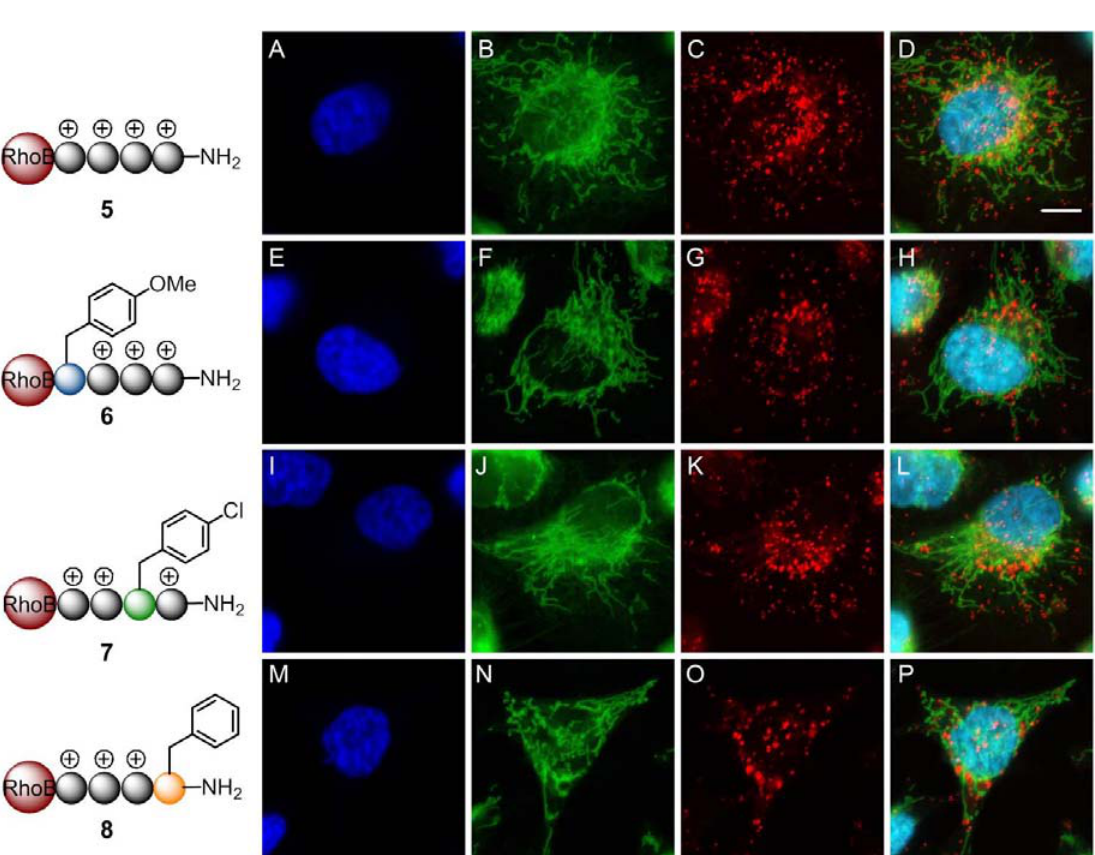
Figure 5. CPPos with endosomal localization . Cellular uptake of endosomal CPPos 5 – 8 in HeLa cells. 1 × 10 4 HeLa wt cells were treated with 1 µM of 5 ( A – D ), 6 ( E – H ), 7 ( I – L